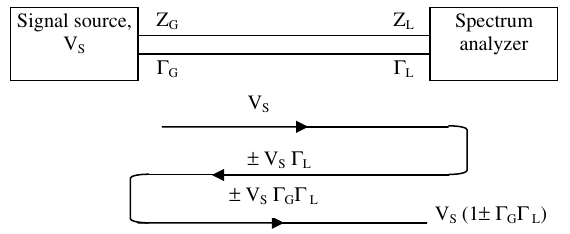
Fig. 1. Effect of mismatch in power measurements, Z G (cid:3) = Z L .